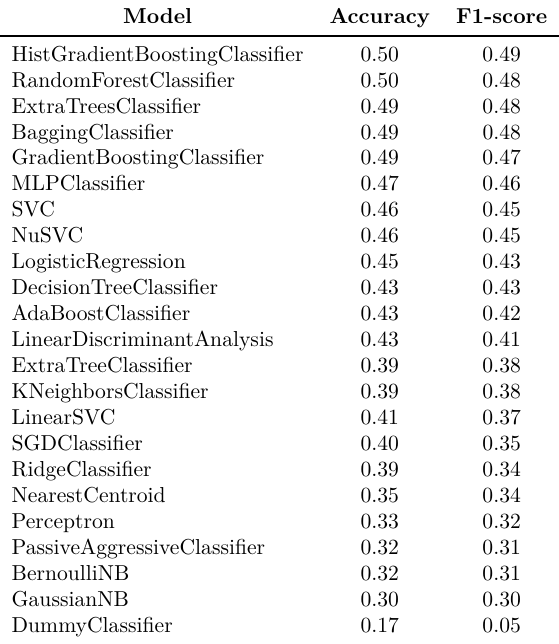
Table 3. Model performances exploration. Models are ordered by F1-scores and then, by their accuracy metrics.